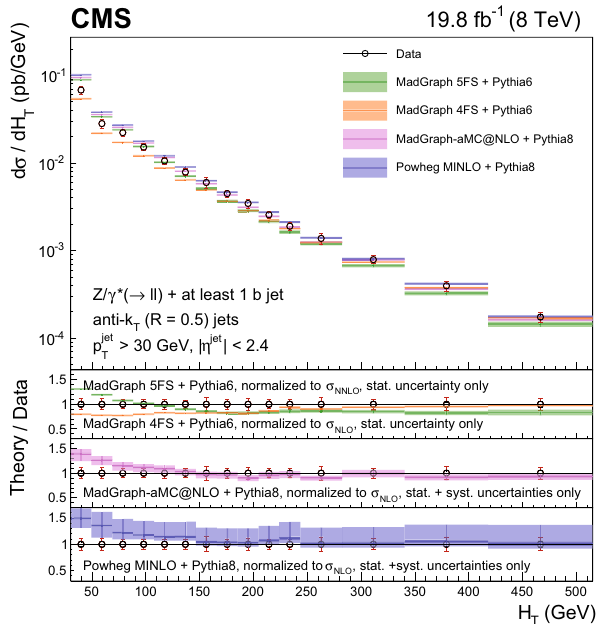
total (sum in quadrature of statistical and systematic) uncertainties are represented by the double error bar . The width of the shaded bands represents the uncertainty in the theoretical predictions, and, for NLO calculations, theoretical systematic uncertainties are added in the ratio plots with the inner darker area representing the statistical component